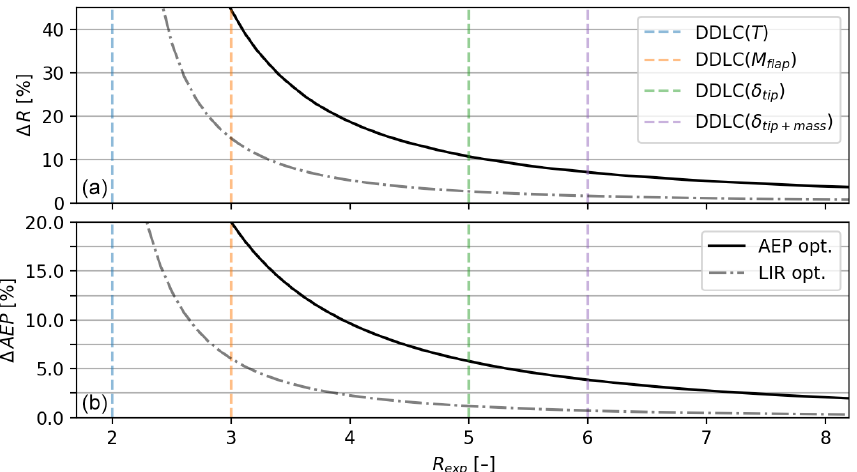
Figure 12. DDLC exponent ( R exp ) vs. (a) relative change in radius ( (cid:49)R ) and (b) relative change in AEP ( (cid:49) ˜ AEP). The plot contains both of the changes for the cases of the low-induction rotor (LIR opt.; dashed–dotted black line) and the AEP-optimized rotor (AEP opt.; black solid). The changes in both AEP and radius are much larger for the AEP-optimized rotor.